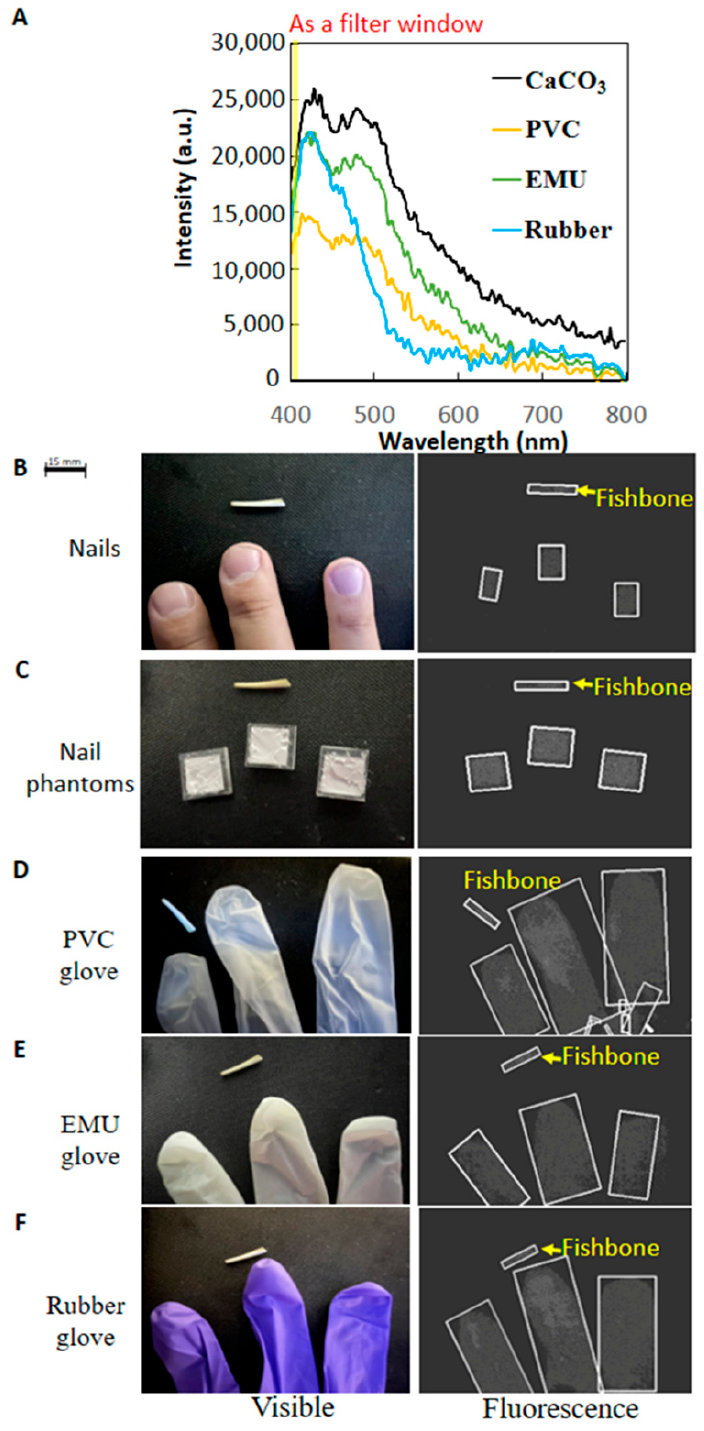
Figure 6. UVA (310 nm)-induced fluorescence spectra and images of exclusion materials also in the form of powder. ( A ) Fluorescent spectra of powders of calcium carbonate and three plastic types (PVC, EMU, and rubber) of commonly used gloves. Fluorescent image of a fish bone as the exclusion target and five samples of ( B ) human fingernails, ( C ) phantom fingernails of calcium carbonate powders, ( D ) fingers of a PVC glove, ( E ) fingers of an EMU glove, and ( F ) fingers of a rubber glove.